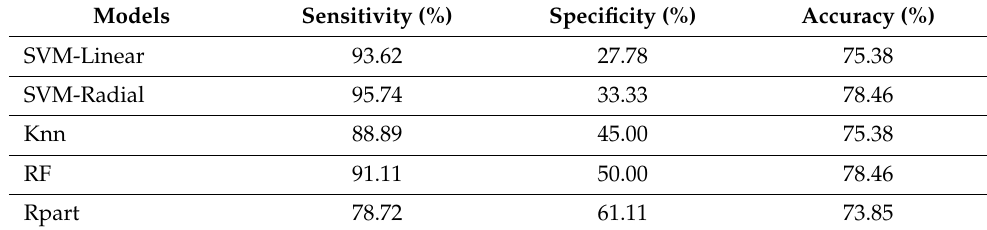
Table 4. Performance evaluation of proposed models by means of sensitivity, specificity, and